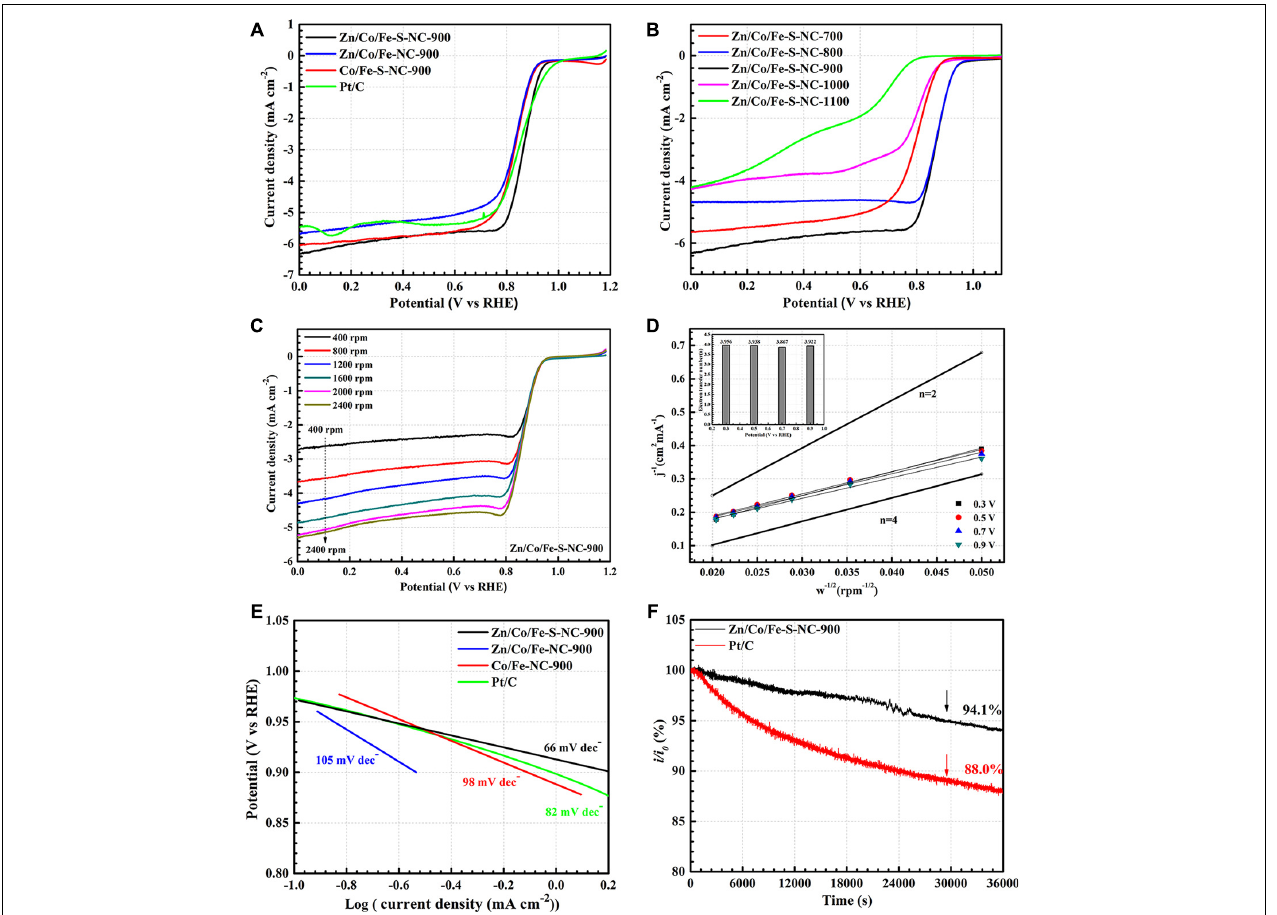
FIGURE 8 | (A) LSV curves of Zn/Co/Fe–S–NC-900, Zn/Co/Fe–NC-900, Co/Fe–S–NC-900, and commercial Pt/C. (B) LSV curves of Zn/Co/Fe–S–NC with different temperatures (700–1,100 ◦ C). (C) LSV curves of the Zn/Co/Fe–S–NC-900 at various rotation rates (400–2,400 rpm) and (D) Koutecky–Levich plots at different potentials (illustration: the calculated ORR electron-transfer number from 0.3 to 0.9 V). (E) Tafel slopes of Zn/Co/Fe–S–NC-900, Zn/Co/Fe–NC-900, Co/Fe–S–NC-900, and commercial Pt/C from LSV curves at 1,600 rpm. (F) Chronoamperometric response of Zn/Co/Fe–S–NC-900 and Pt/C at 0.65 V (vs. RHE). (All LSV curves were conducted on RDE in O 2 -saturated 0.1 M KOH solution with scan rate of 5 mV s - 1 and the rotation rate of 1,600 rpm.)